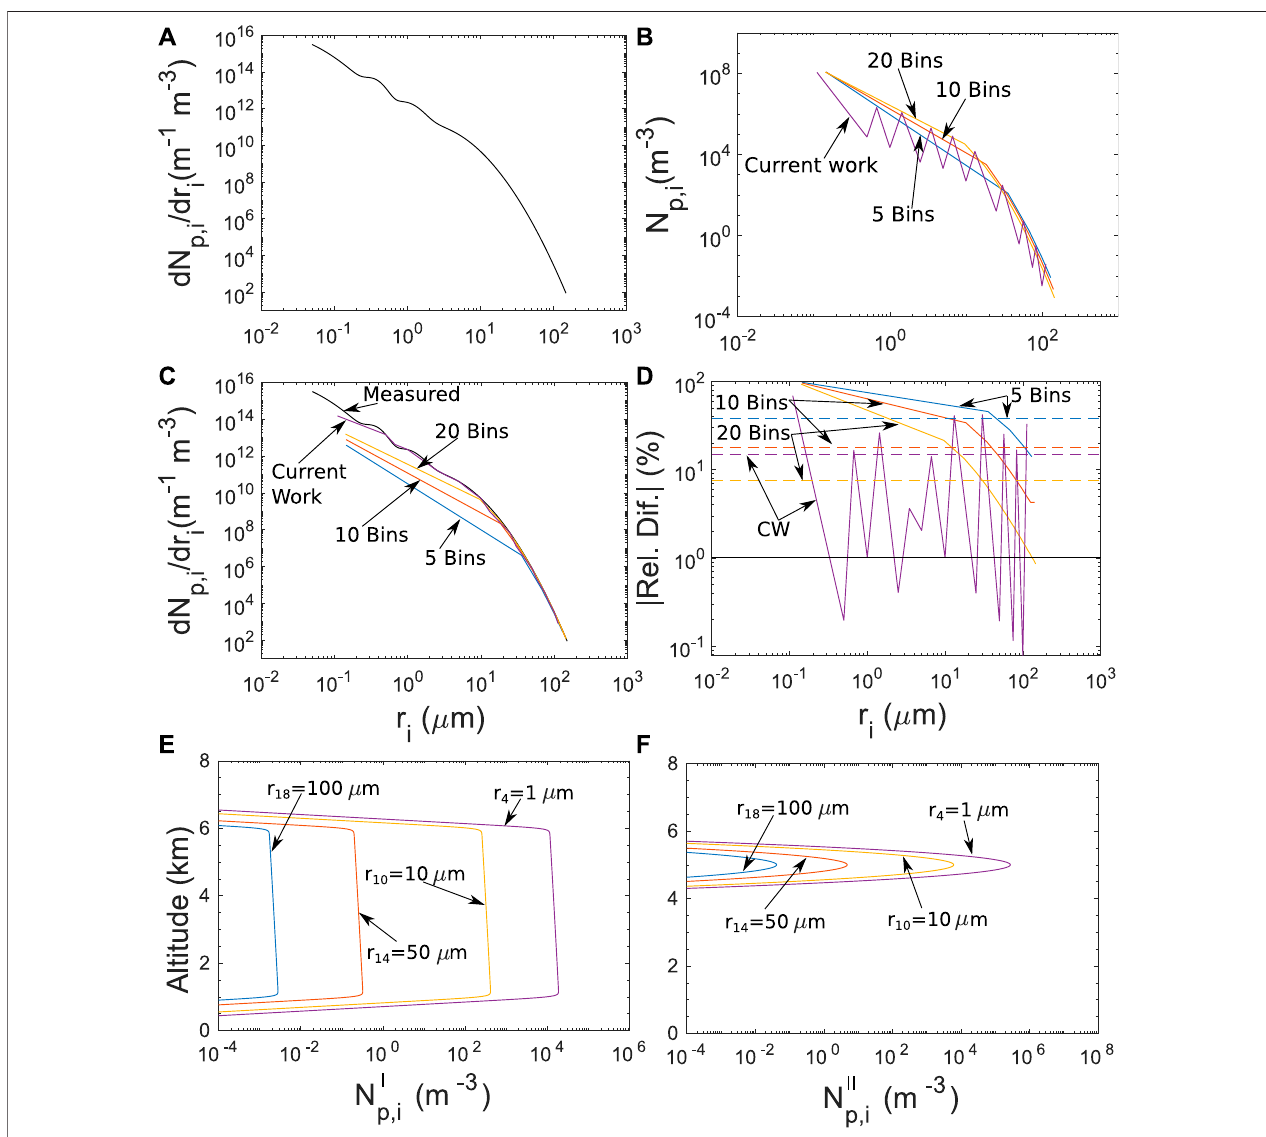
FIGURE 5 | Particle number density distributions: (A) measured mean normalized number density distribution by Ryder et al. (2013b), (B) number density distribution for different binnings, (C) reconstructed normalized number density distributions, (D) relative difference between the reconstructed normalized number density distributions and the measured one, with dashed lines being the average values, (E) N I p , i and (F) N II p , i .